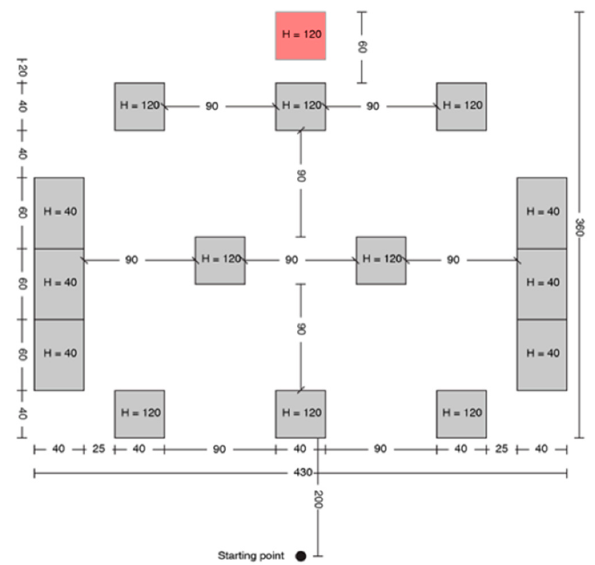
Figure 6. TH configuration B.